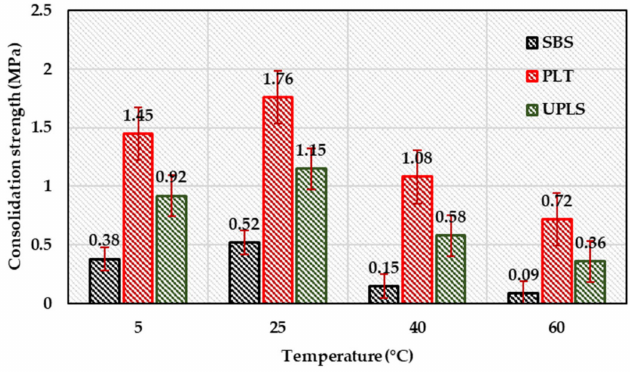
Figure 16. Consolidation strengths of the three waterproof coatings at di ff erent temperatures.